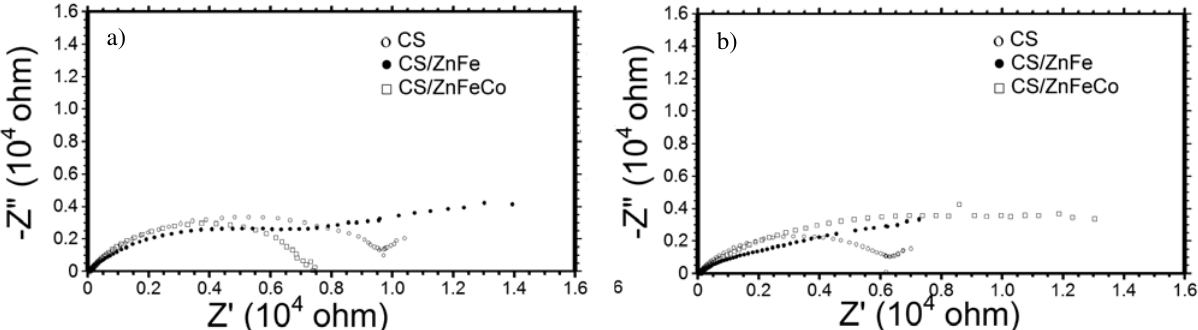
Fig. 6. The Nyquist curves of electrodes, after (a) 48 h and (b) 168 h of exposure time in 3.5% NaCl solution. Table 1. Impedance data obtained by simulation of Fig. 6. β